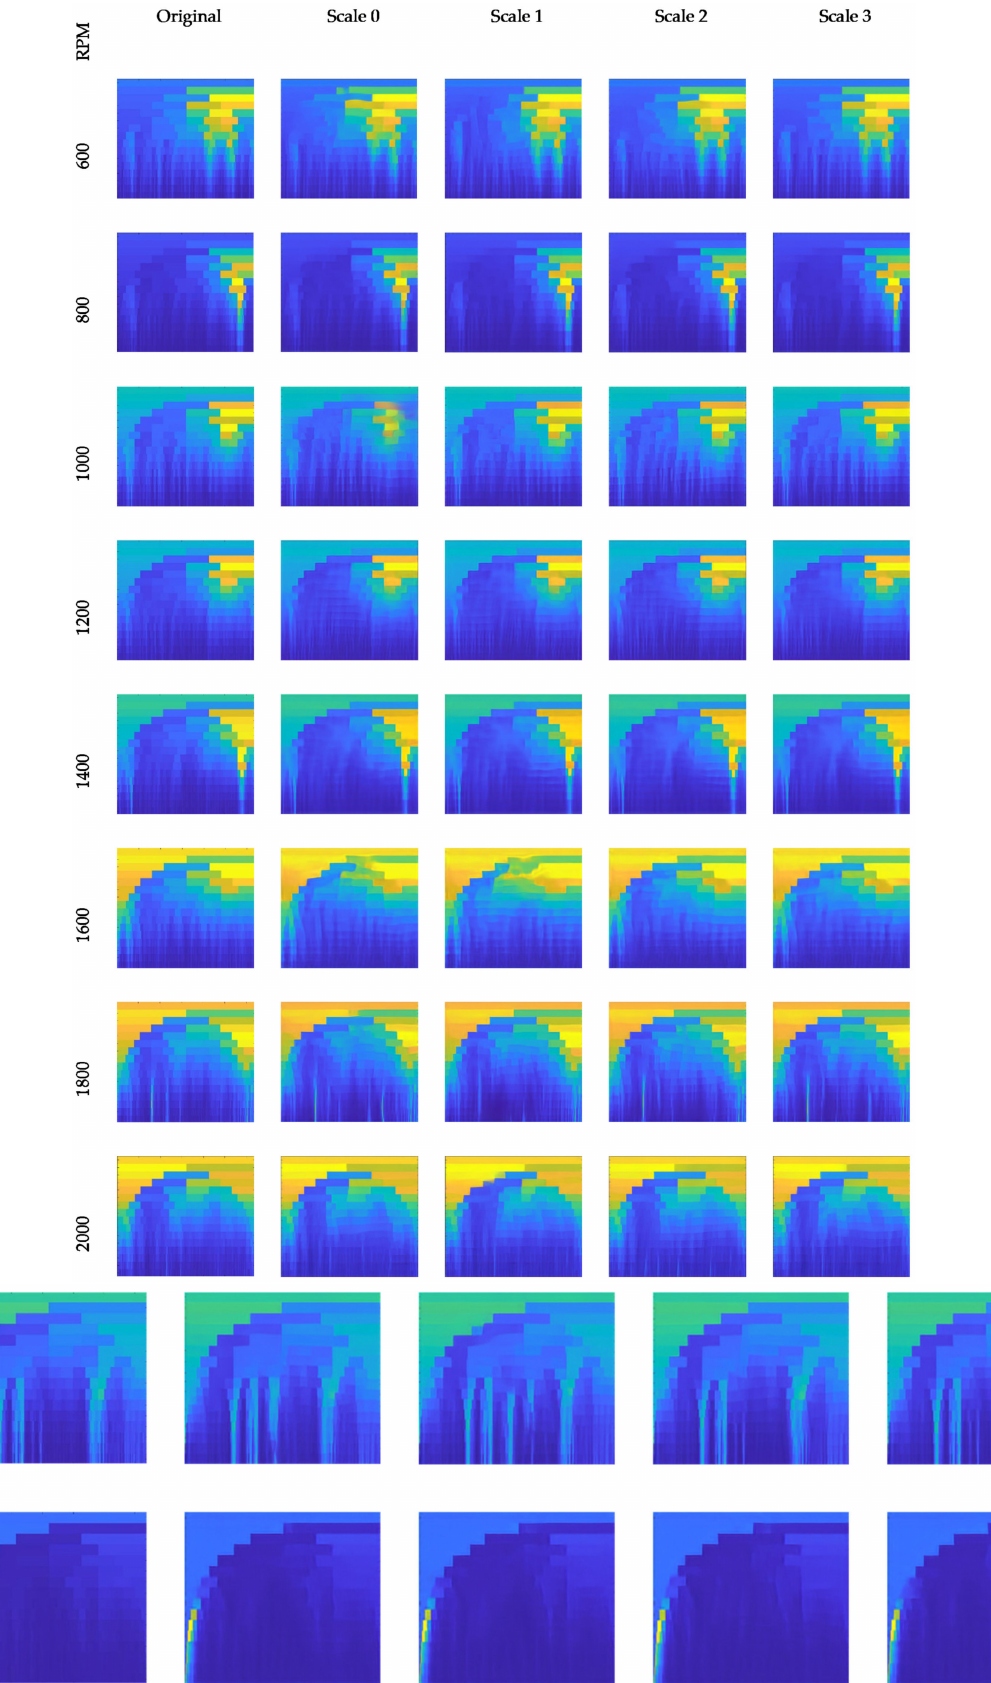
Figure 10. Kurtogram generation using SinGAN at various